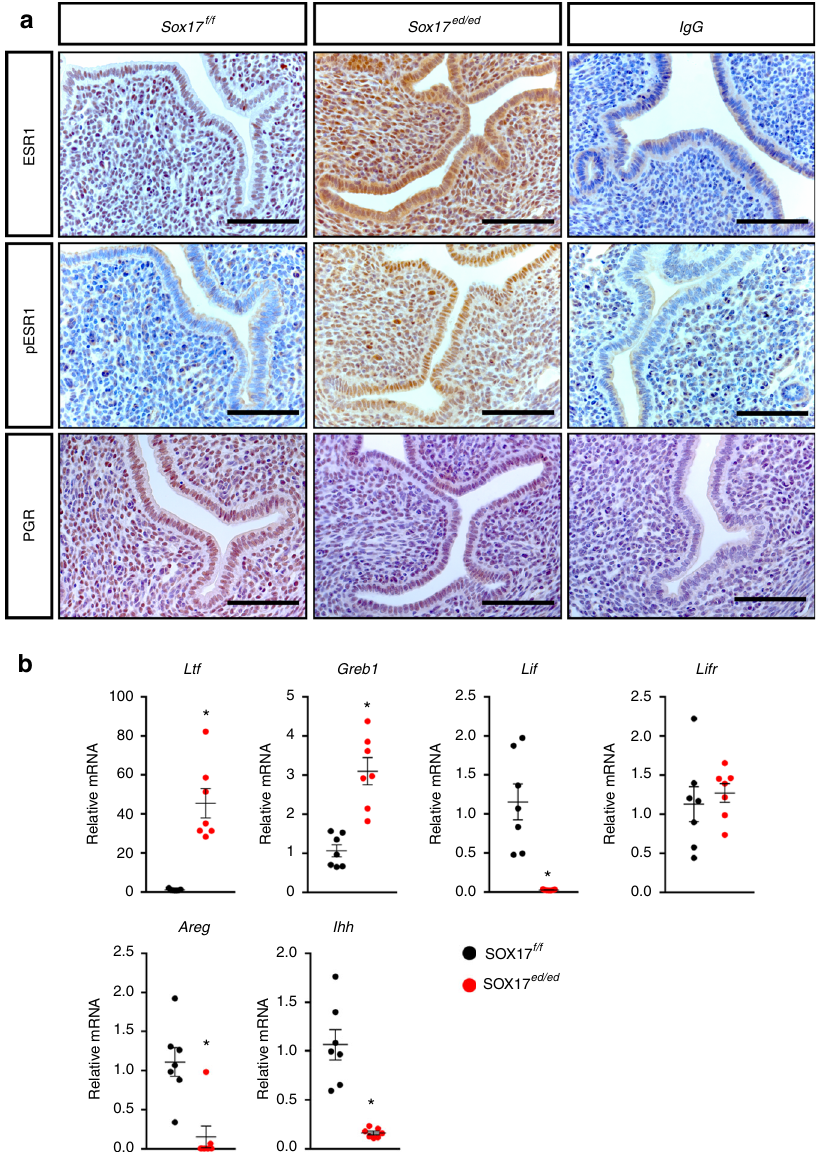
Fig. 2 Dysregulated estrogen and progesterone signaling in Sox17 -de fi cient uterus during the window of receptivity. a Immunohistochemical staining of ESR1, phosphorylated ESR1 and PGR in GD 3.5 uteri from Sox17 f/f and Sox17 ed/ed mice ( n = 3). IgG staining as the negative control. Scale bars: 100 µ m. b Quanti fi cation of ESR target genes ( Ltf, Greb1, Lif, Lifr ), as well as PGR target genes ( Areg, Ihh ) in GD 3.5 uteri from Sox17 f/f (black dots) and Sox17 ed/ed (red dots) mice ( n = 7). * P < 0.05 (Student ’ s t test). Data are presented as means ±